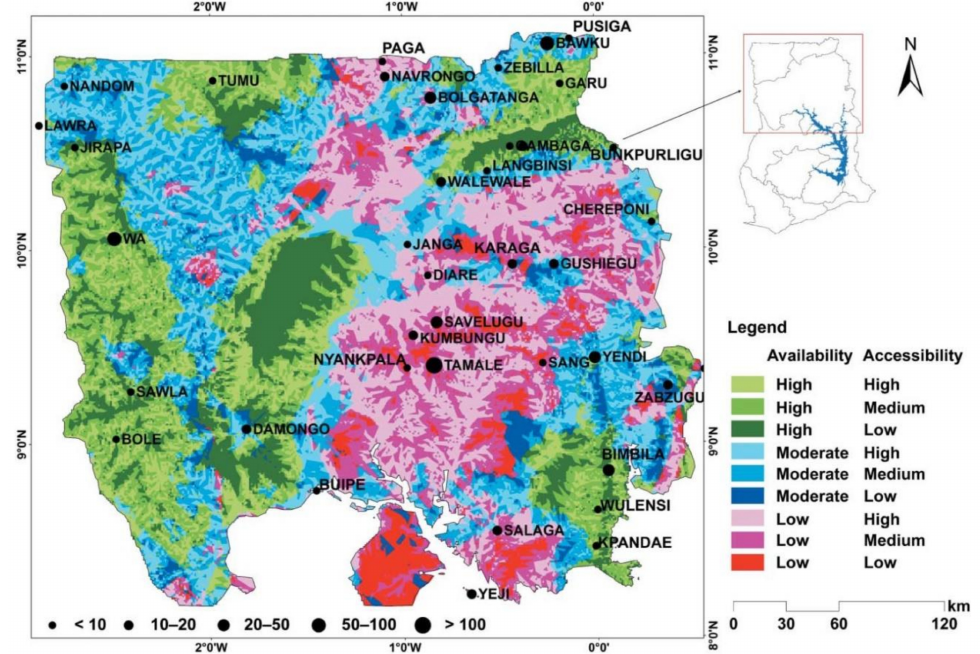
Figure 1. Groundwater development potential map of northern Ghana. Source: Copied from Forkour et al.